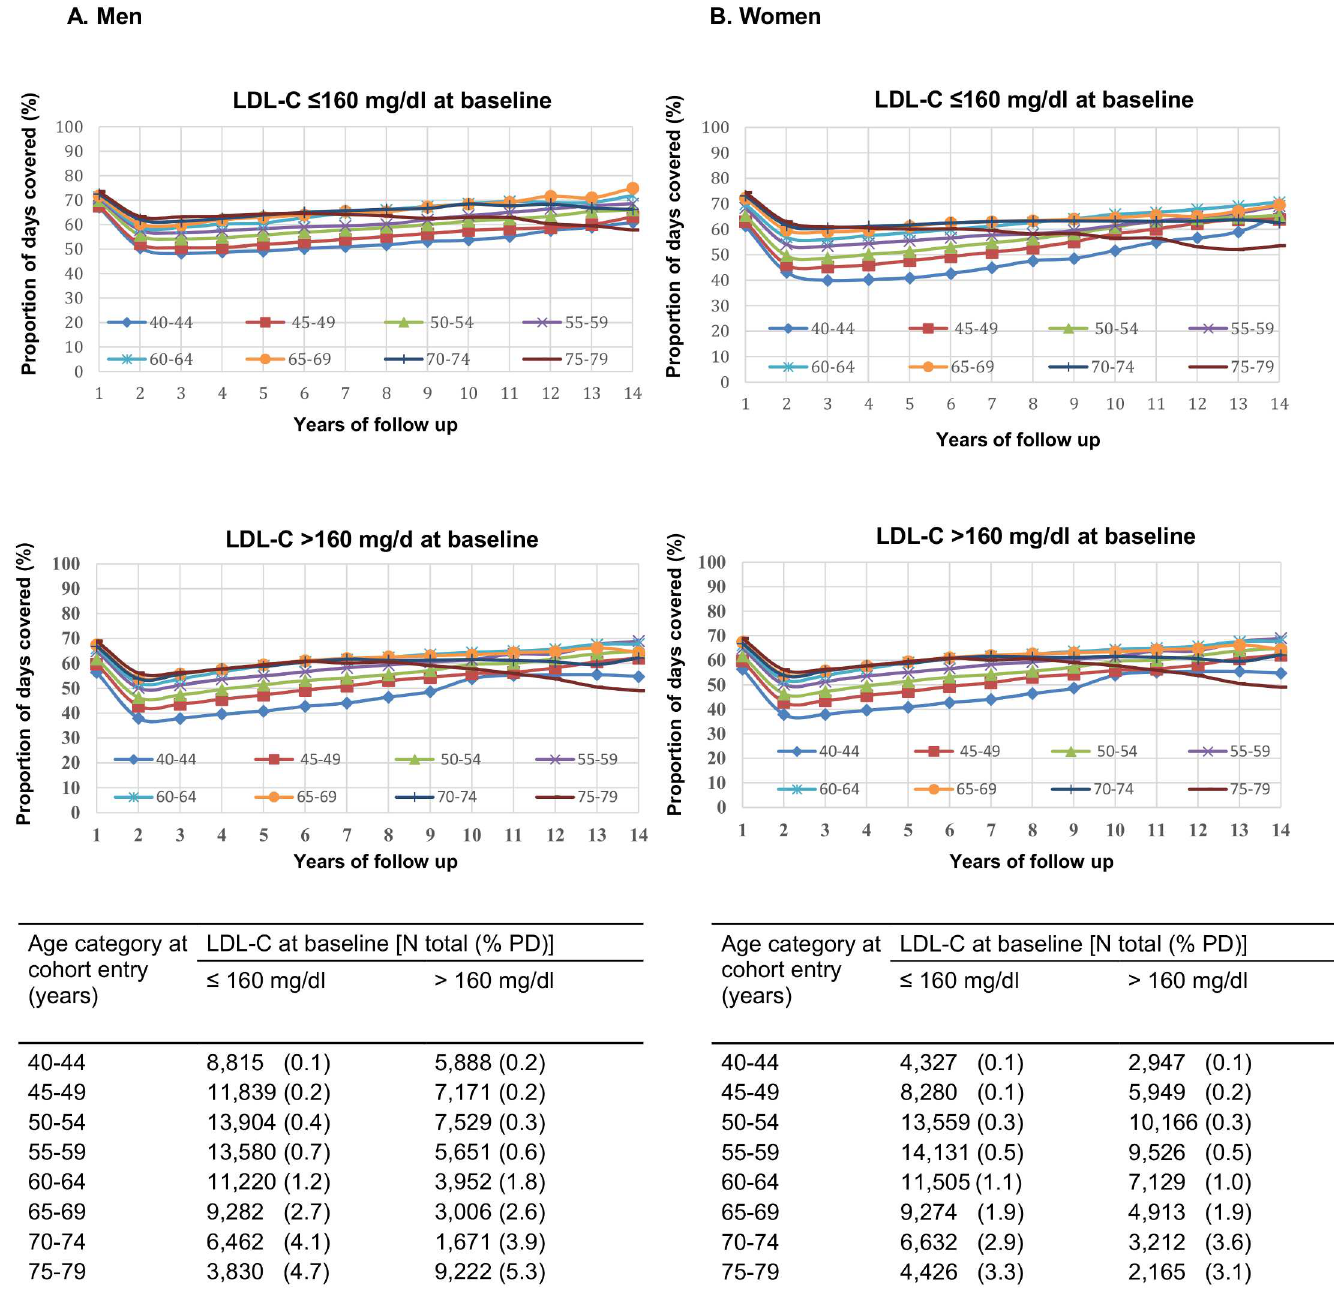
Fig 2. Annual changes in statin adherence * (expressed by proportion of days covered-PDC): according to sex, LDL-C level at baseline and age category (results of mixed models). * First annualPDC measuresare based on the FU interval from the first month of statin purchaseuntil the month of December of that calendar year. Last annualPDC measures are based on the FU interval from Januaryof that year until the end point. Other annualPDC measuresrepresent a full calendaryear (12 months). https://doi.org/10.1371/journal.pone.0175054.g002 men and women and across all age categories (Fig 3). All-risk estimates were close to unity except for the slightly reduced PD risk: HR = 0.77 (95%CI 0.44-1.34) among women aged 40-